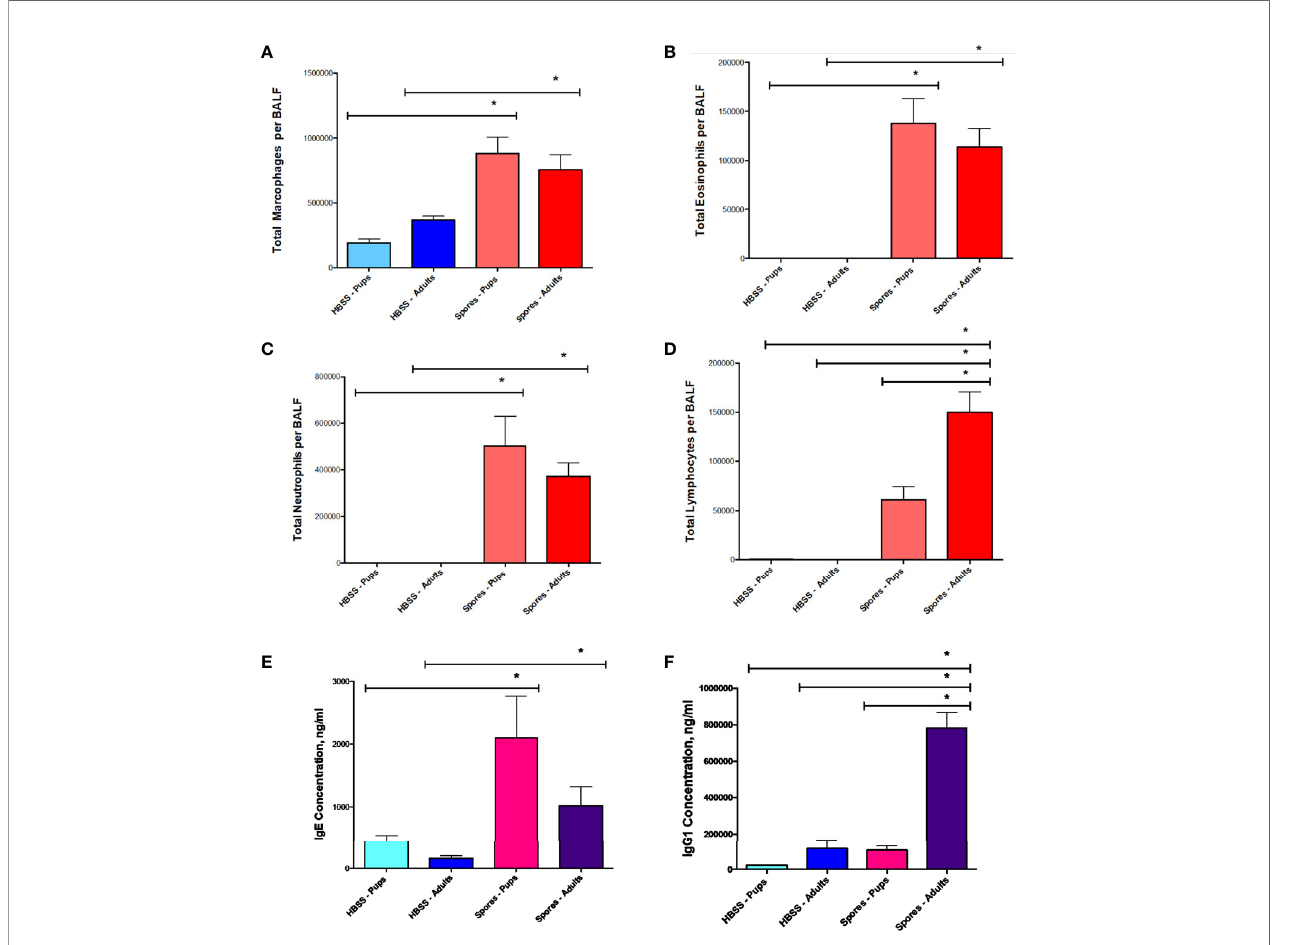
FIGURE 5 | BAL cell counts and serology in adults or neonates. Data represents mean ± SEM, n = 8-10/group. *P < 0.05. (A – D) Differential cell counts. Different cell types in BAL samples were counted from these mice and presented as the total cells. (E, F) Serological testing for total serum IgE and